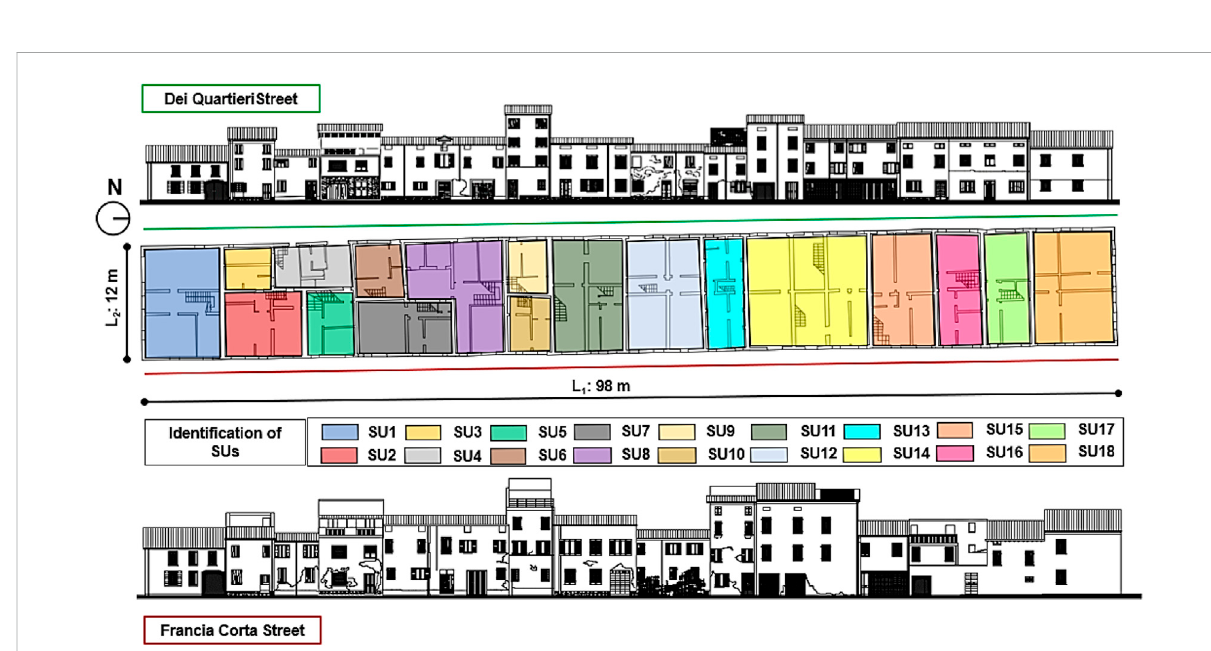
FIGURE 9 Division in SU of the masonry building compound in Mirandola (district of Modena, Italy).